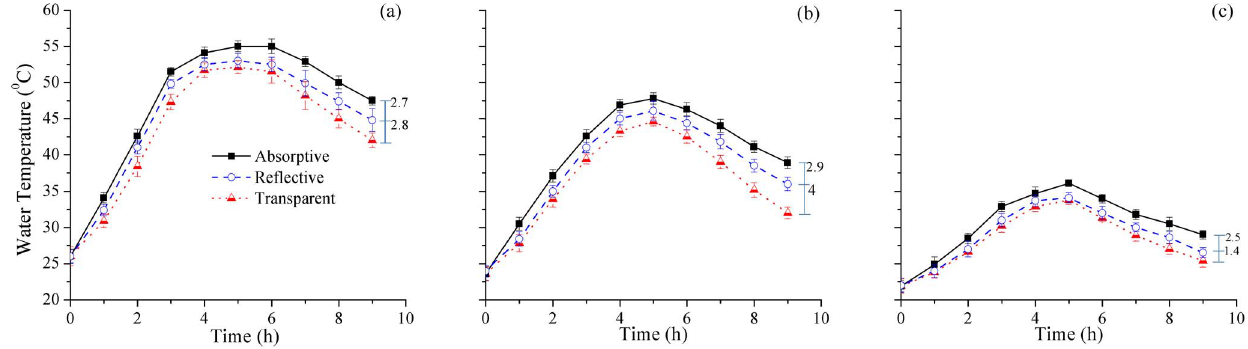
Figure 3. Temperature change in PET bottles with different rear surfaces against exposure time under (a) sunny, (b) mild, and (c) weak weather conditions.